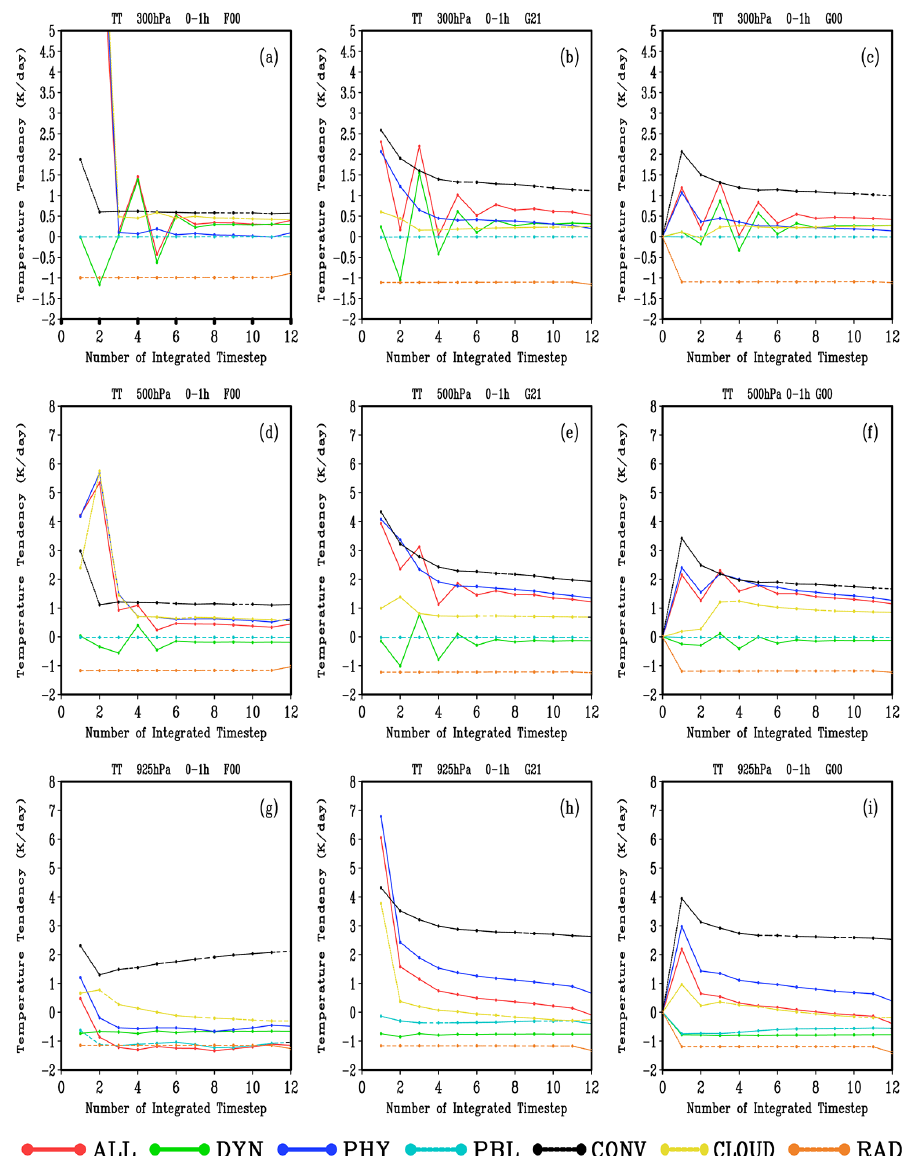
Figure 3. The same as Fig. 2 but for the results of temperature tendency. (values given in Kd − 1 ).